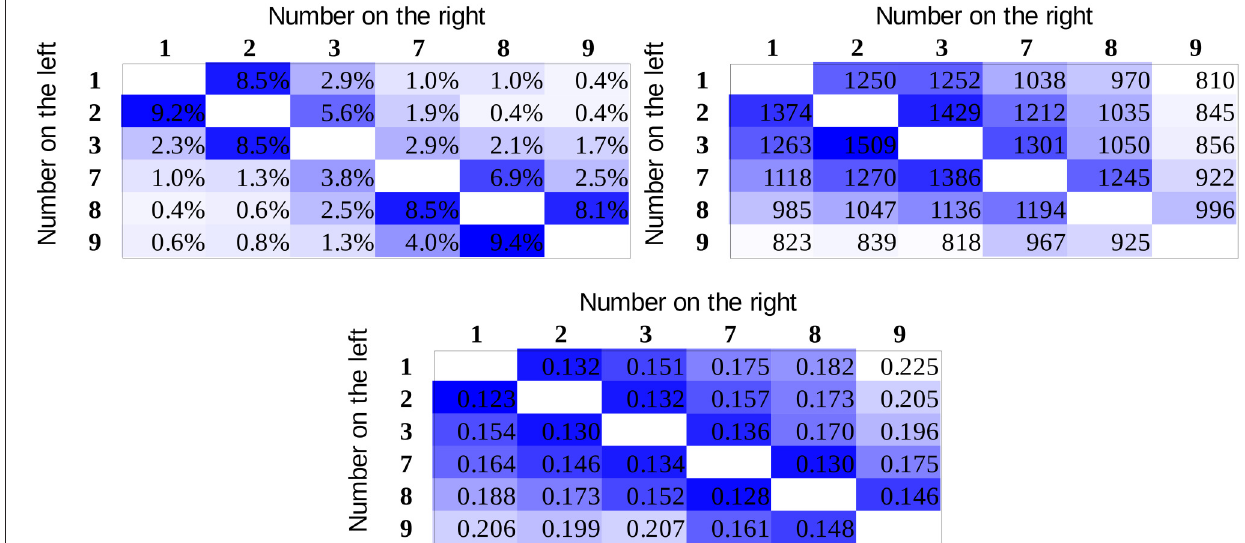
Frontiers in Psychology |